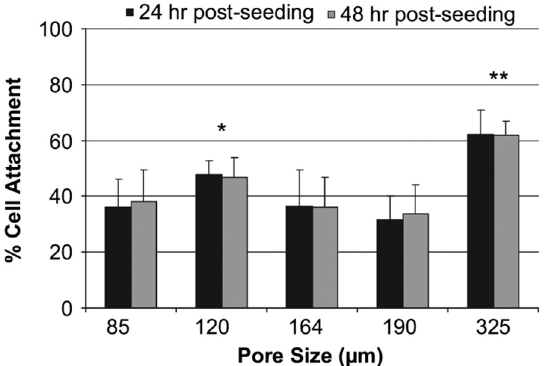
Figure 2: The relationship is shown between mean pore size and cell attachment.Cellscultured onsca ff old with pore sizeof325 μ m shows the highest percentage of cell adhesion ( reproduced from ref. [ 31 ]) .